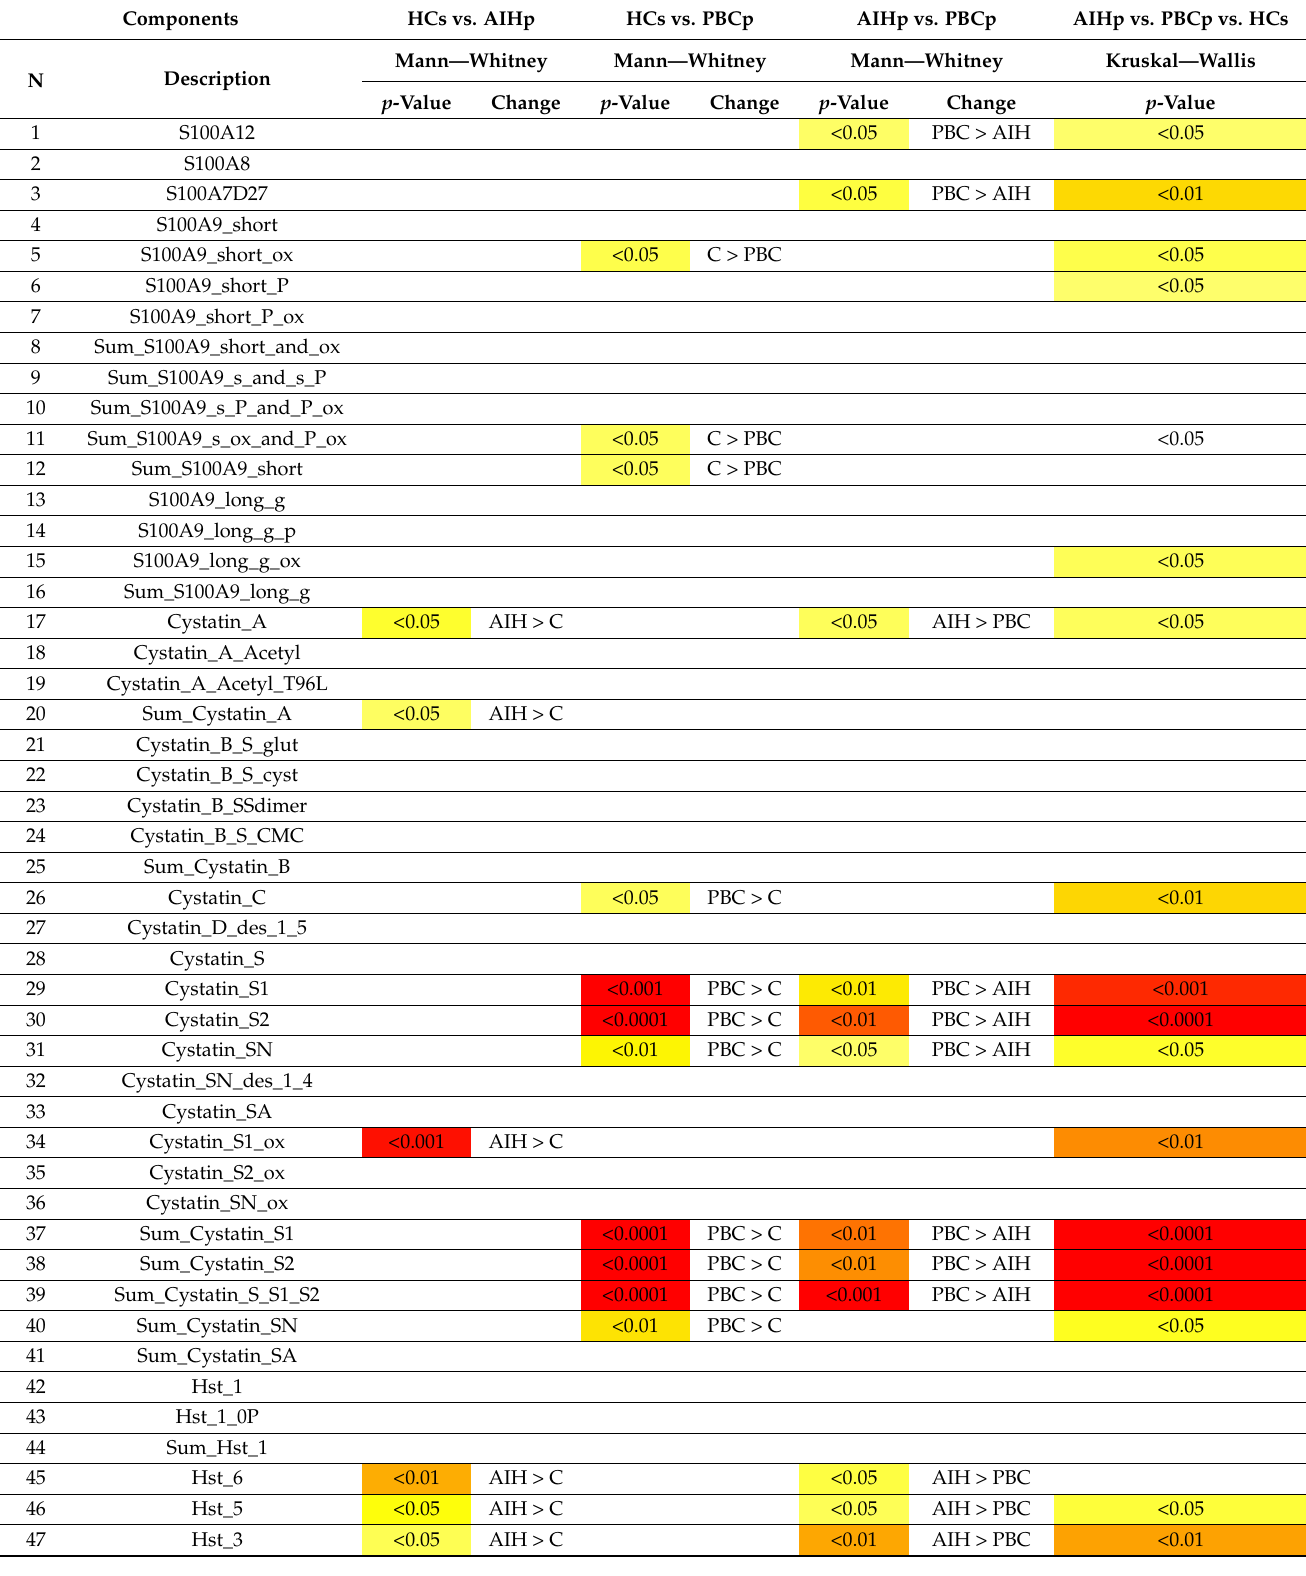
Table 2. Comparisons between HCs, AIHp and PBCp. For each pairwise comparison, two columns are reported: the first column shows the Mann—Whitney significant p -values, highlighted by color tones ranging from yellow to red; the second column shows the direction of the change. The last column on the right shows the results of the ANOVA-analogue nonparametric Kruskal—Wallis